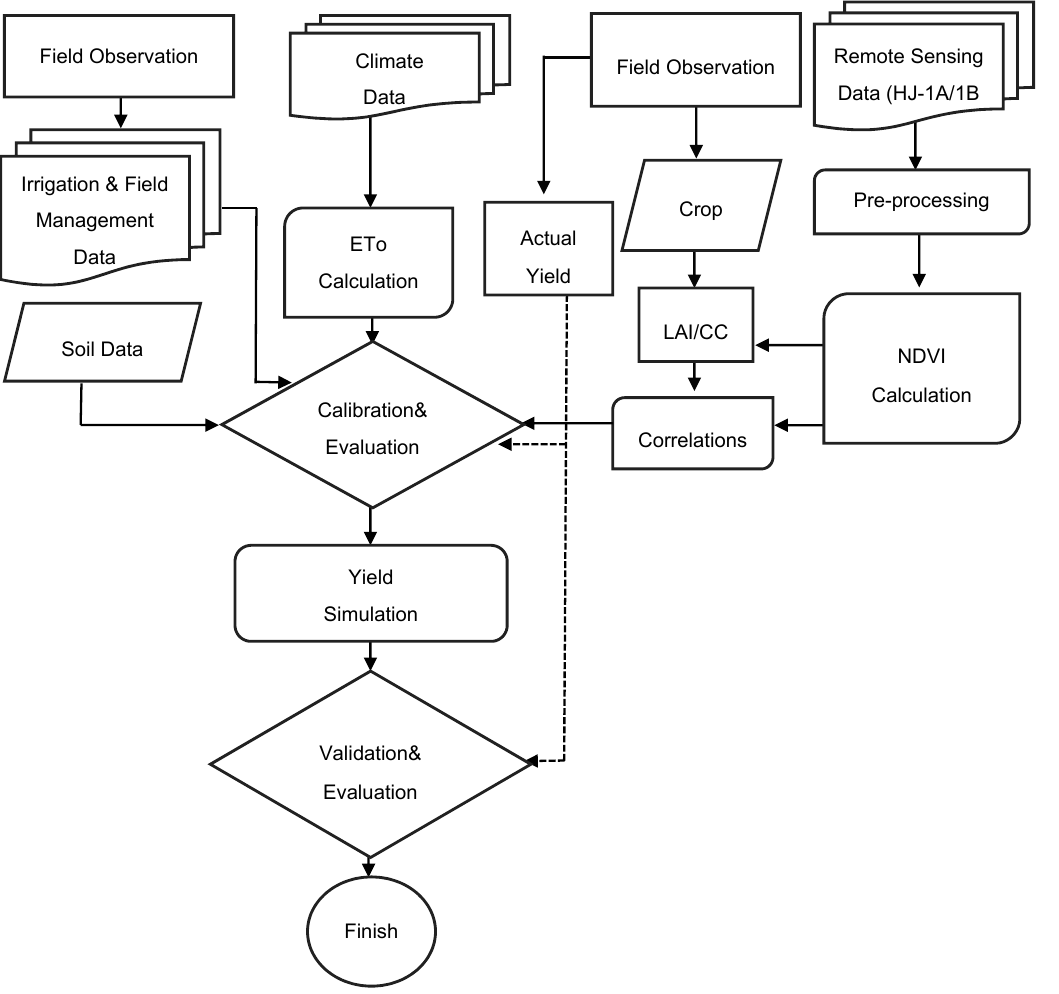
Figure 2. Flowchart showing the methodology used in this study. See text for full details.